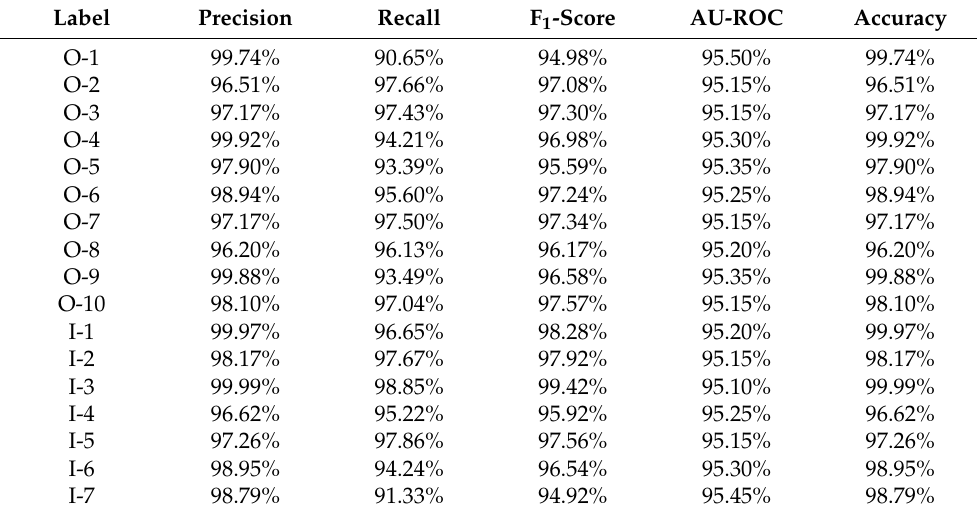
Table 2. Performance metrics for each type rolling bearing